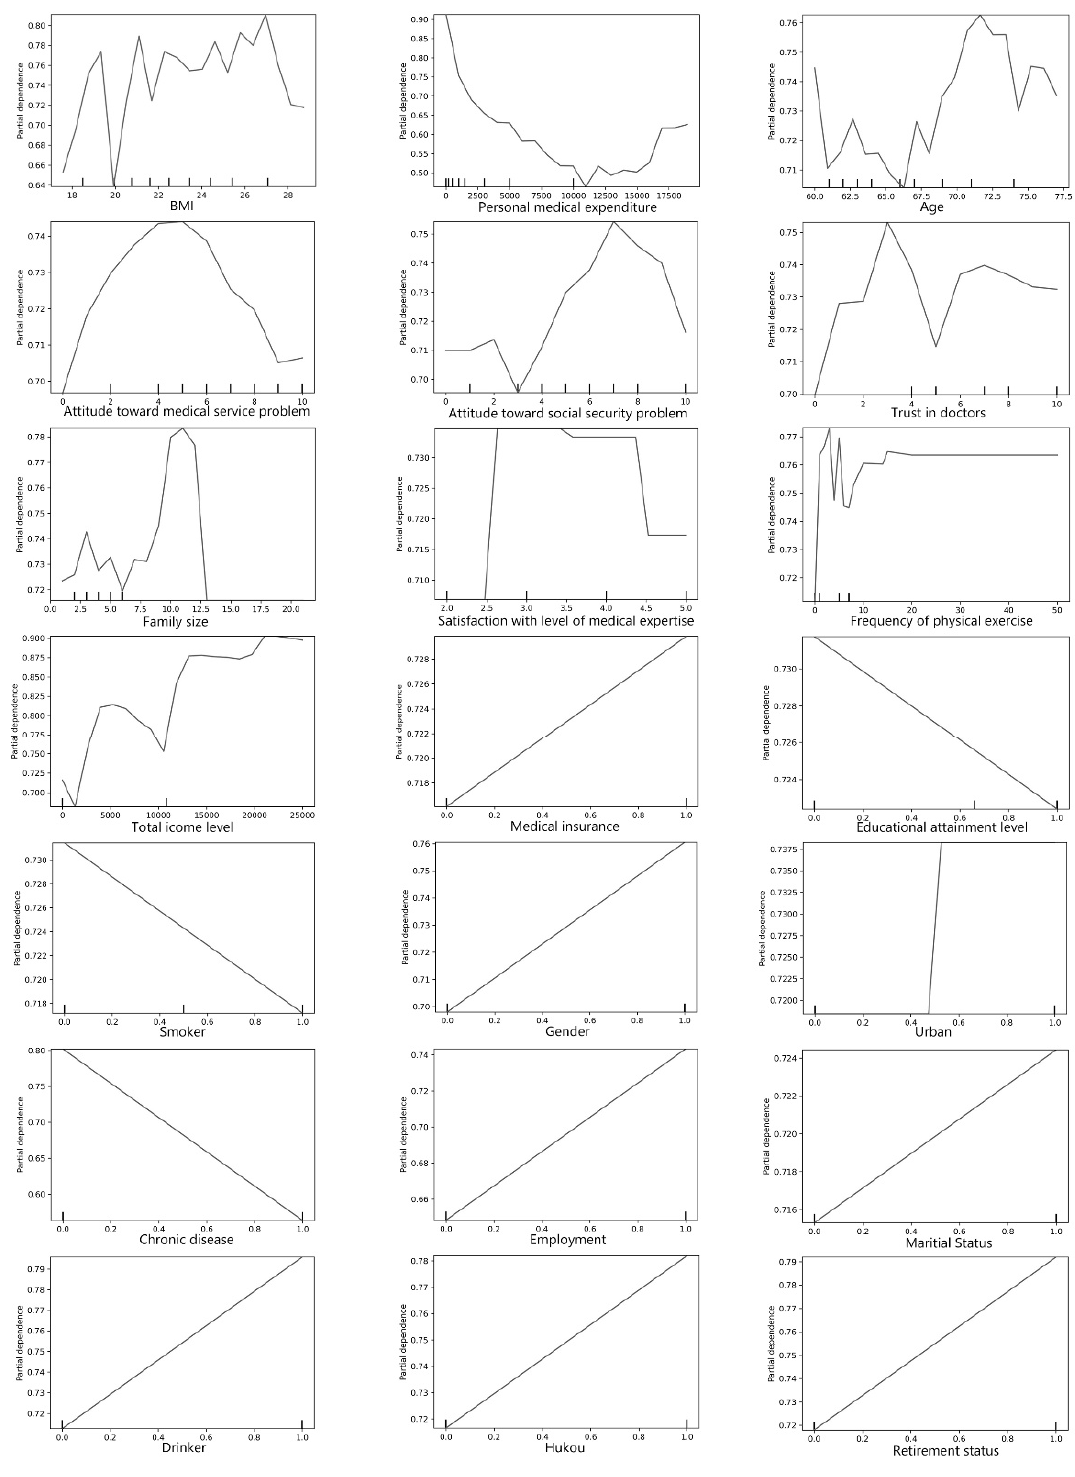
Figure 1. Nonlinear association between factors and older adults’ SRH (Note: Y-axes represent log- odds).